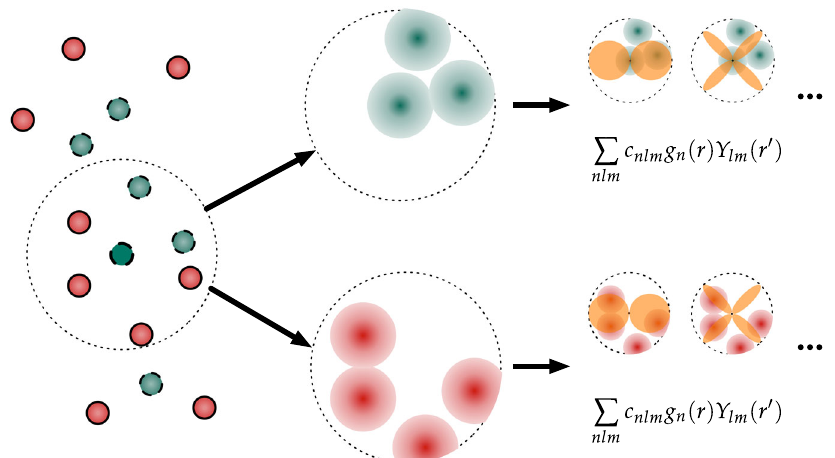
Fig. 4 Smooth overlap of atomic positions. The local density around a central atom is modeled by atom-centered normal distributions and expanded into radial and spherical harmonics basis